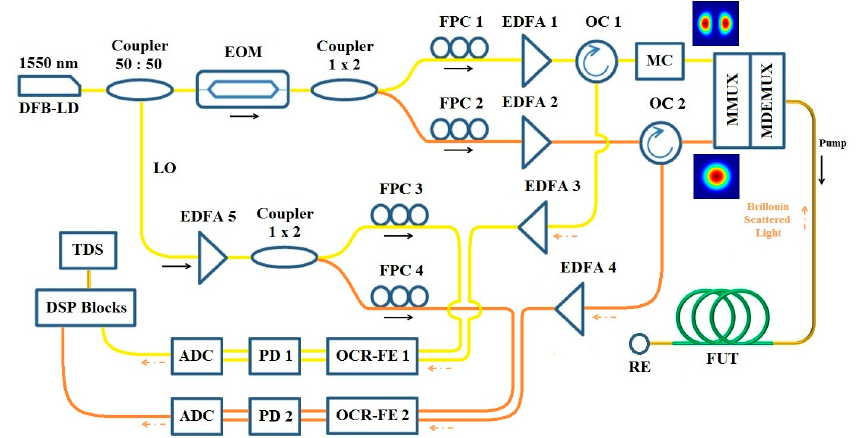
Figure 11. Configuration of BOTDR using FMF for simultaneous temperature and strain sensing.